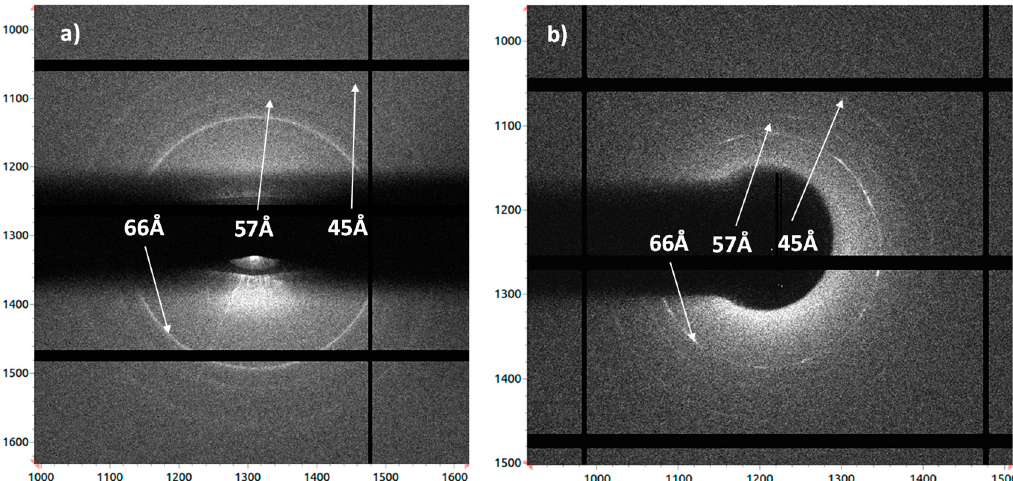
Figure 1. X-ray diffraction images of optimized anti-cluster of differentiation 20 (CD20) crystal powder obtained in the same crystallization conditions (60 mg/mL of antibody, 770 mM sodium sulfate, and 24 wt.% PEG400 in batch set-up) collected at Diamond Light Source ( a ) and ESRF ( b ) synchrotrons, using primary X-ray beams at 6 keV and 7 keV, respectively. The data resolution of the diffraction rings is shown. The uneven ring intensity in Figure 1b can be ascribed to the non-uniform orientation of crystallites.